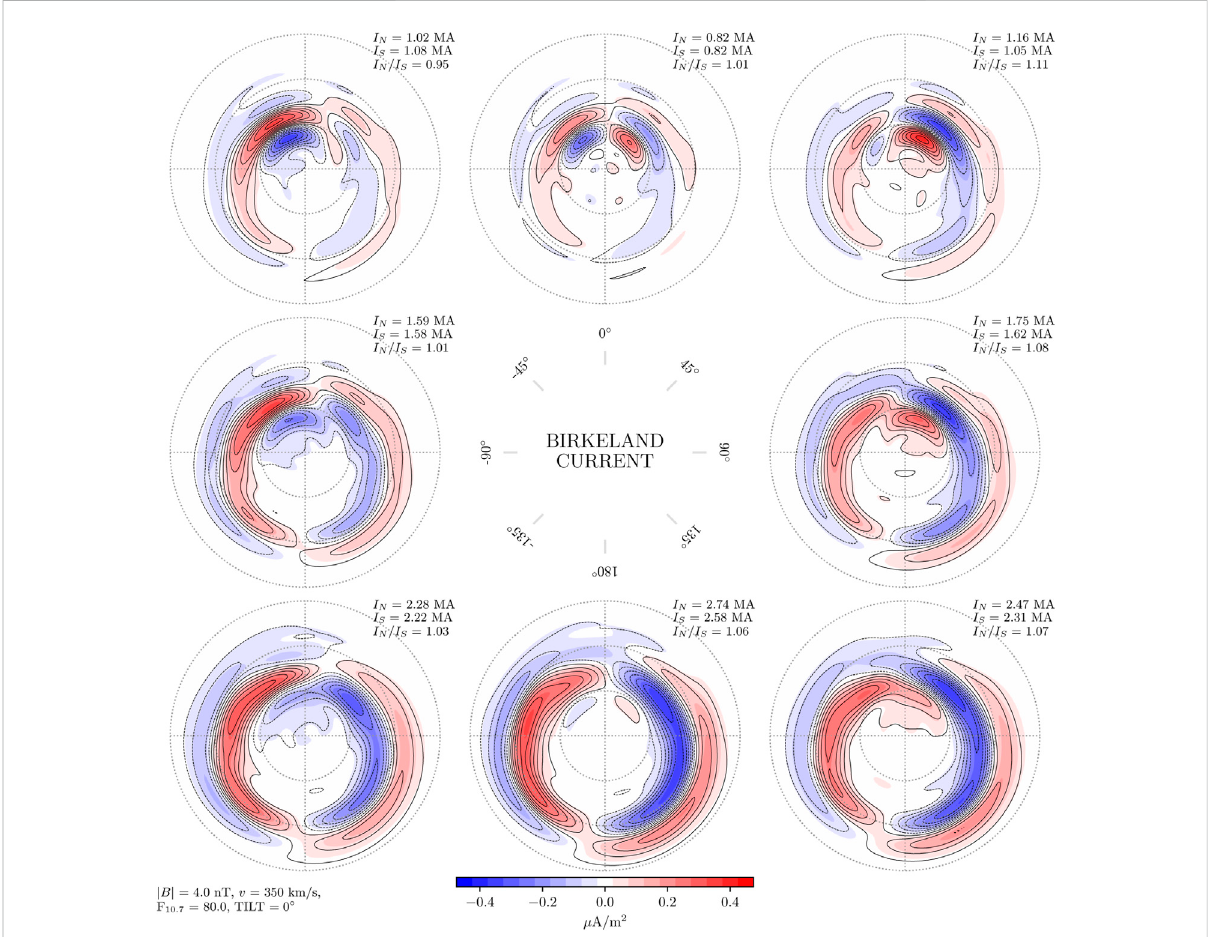
FIGURE 3 Amplitude of Birkeland currents in the Northern Hemisphere (colored contours) and Southern Hemisphere (black contour lines) for dipole tilt angle ψ =0 ° ,inthesamelayoutasFigure2.Inthis fi gurethemeanhemisphericallyintegratedcurrentintheNorthernHemisphereis4%strongerthan in the Southern